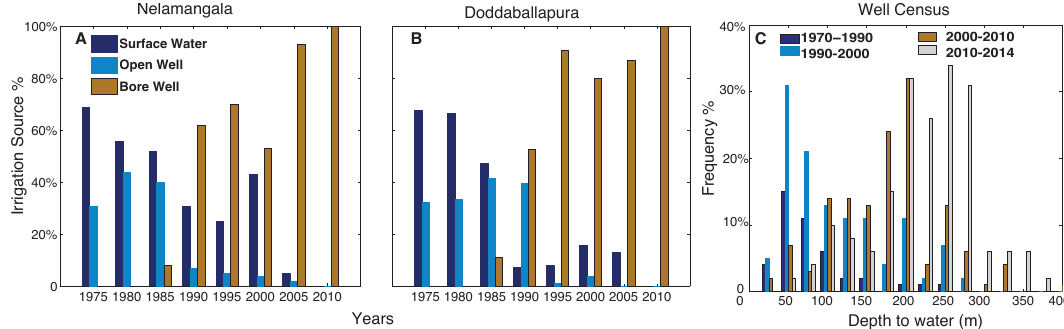
Figure 3. Water use in the TG Halli catchment. (a, b) Sources of irrigation water used over time in two taluks (local government areas), indicating the reduction in surface and shallow well use and their replacement by deep borehole over time. Data Source: Department of Economics and Statistics, Karnataka. (c) Depths at which water was encountered at time of drilling. Data from well census conducted by ATREE field hydrology team in summer of 2014 covering 482 boreholes in a 26sqkm area in TG Halli